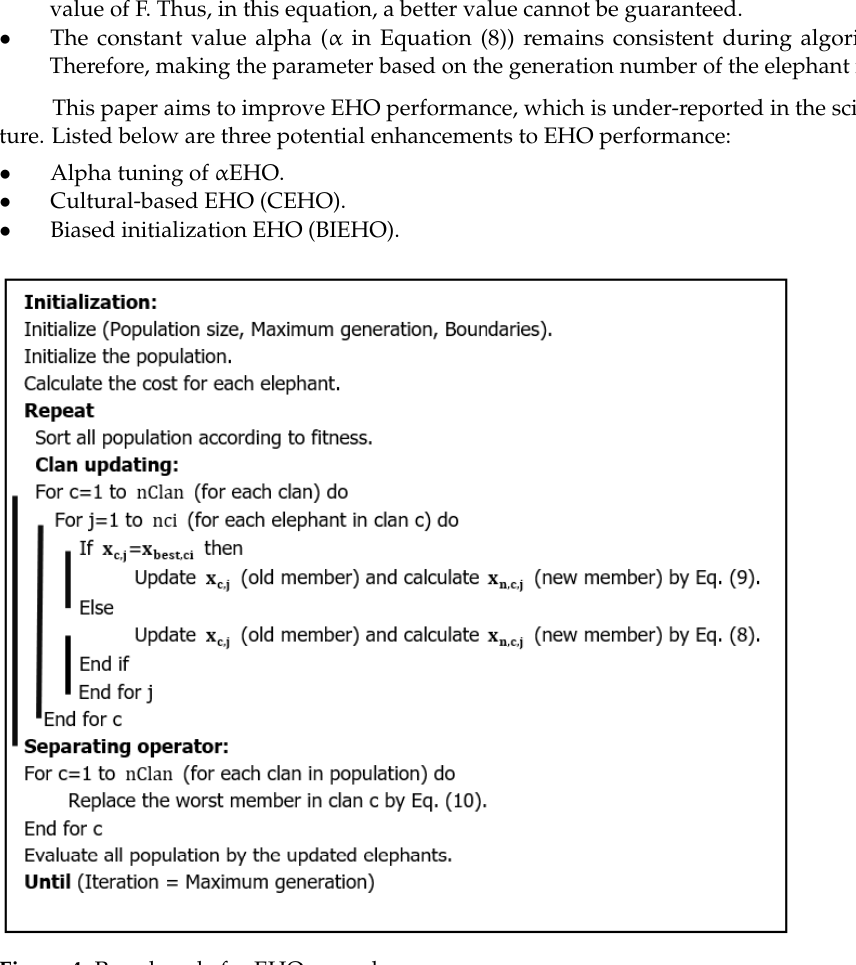
Figure 4. Pseudocode for EHO Figure 4 . Pseudocode for EHO procedure.